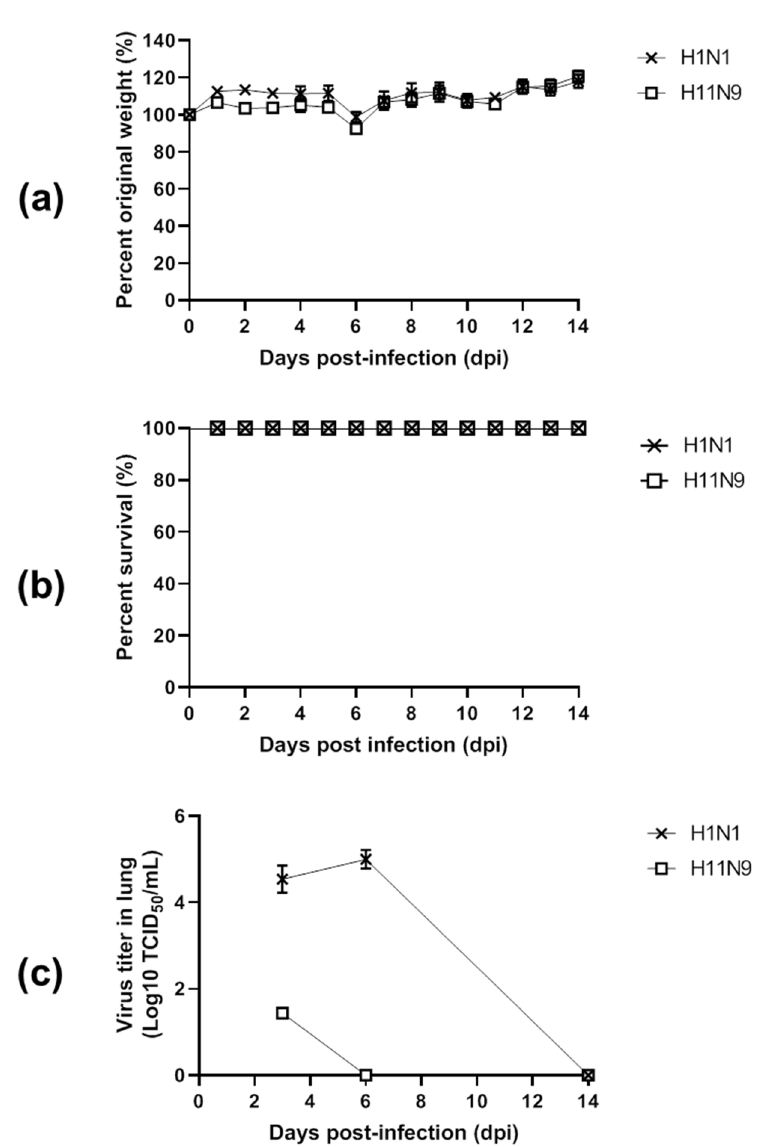
Figure 4. Pathogenicity of H11N9 virus in vivo. Balb / c were intranasally challenged with 10 5 EID 50 of virus. H1N1 was used as a control virus. Mice weight ( a ) and survival rate ( b ) were observed for 14 dpi. Body weight was presented as % of those of original mice ( n = 5). Mean virus titers in the lungs of mice ( n = 3) were measured at 3, 6, and 14 dpi ( c ).